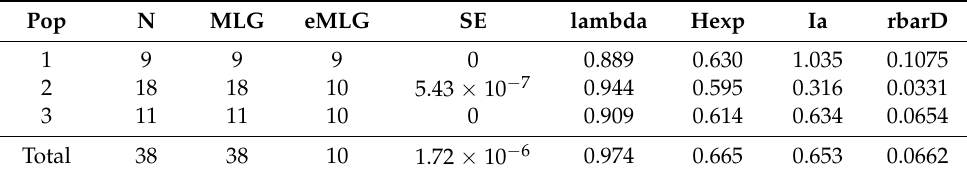
Table 6. Diversity indices for SSR data grouped according to DAPC